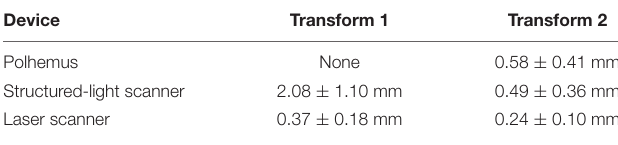
TABLE 2 | Surface fit error of each device in the reference phantom